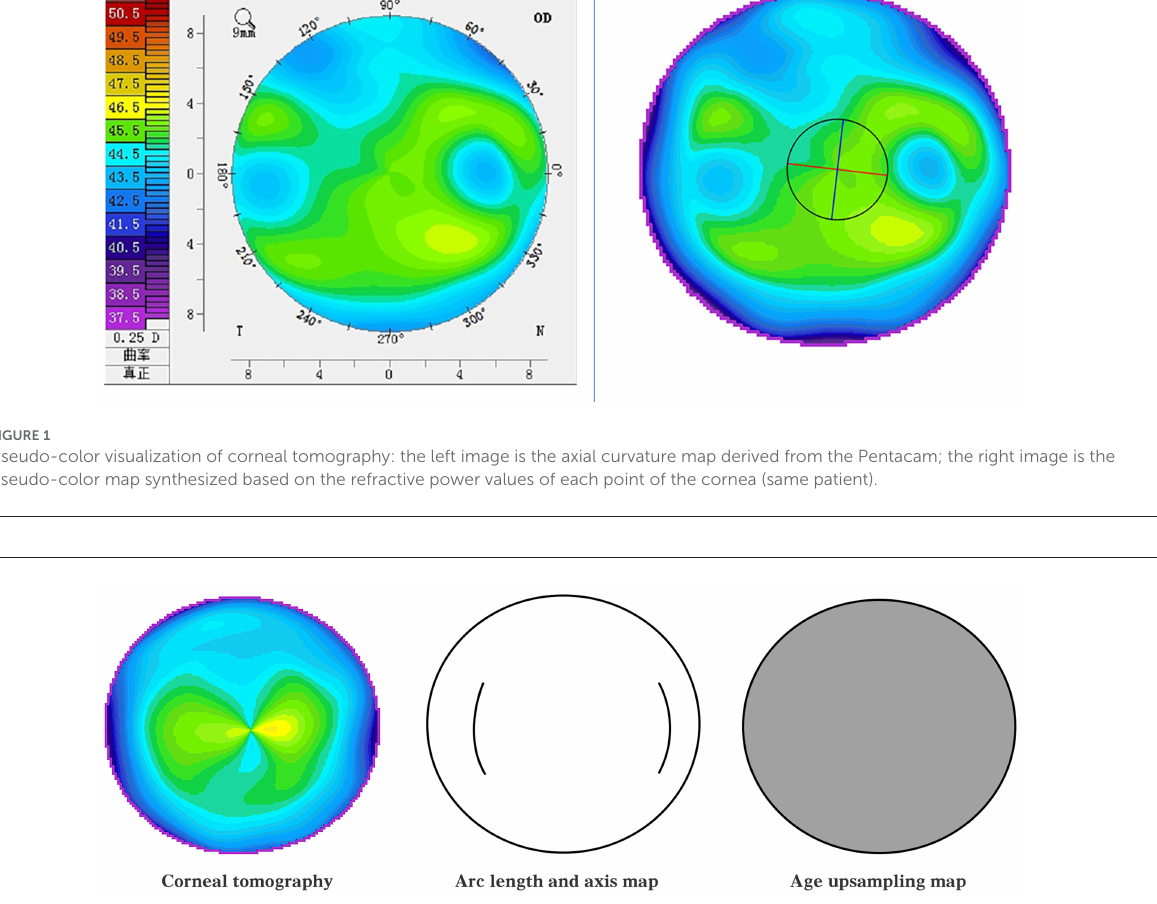
FIGURE2 Inputs to the predictive